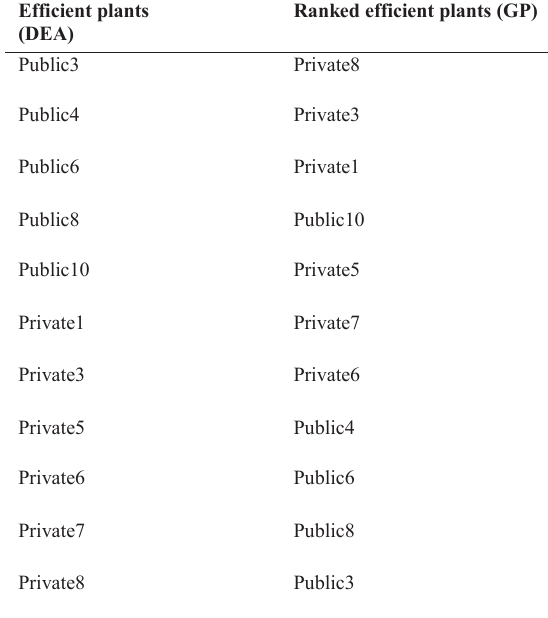
Table 7. Ranking of power plants according to the operational